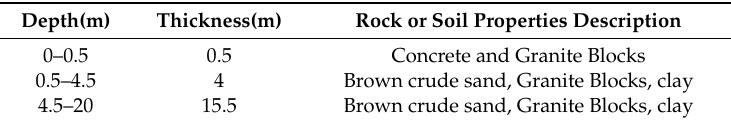
Table 2. List of drilling data for Shangyi Airport in Kinmen.